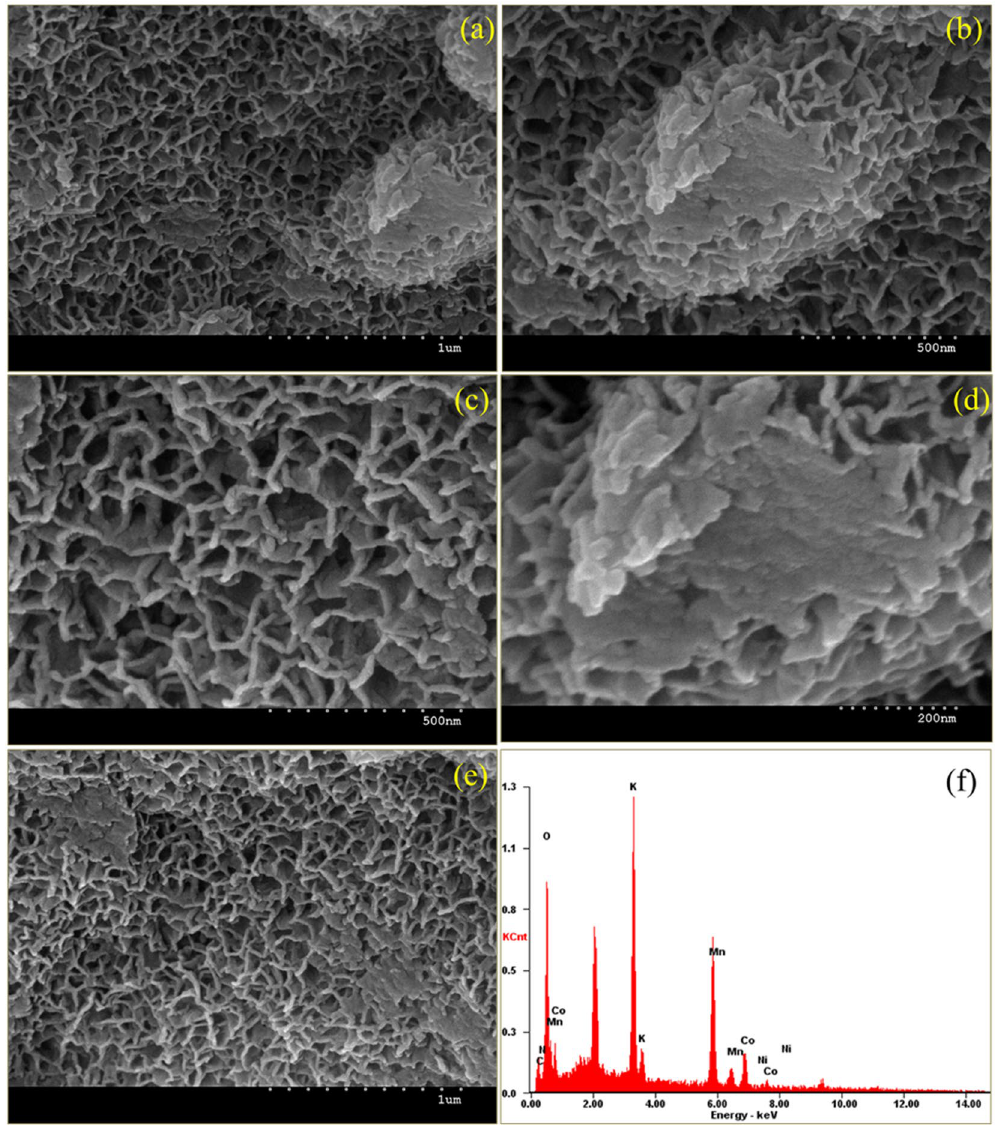
Figure 4. ( a – e ) FE-SEM morphology and ( f ) SEM-EDX of Co 3 O 4 @MnO 2 /NGO hybrid